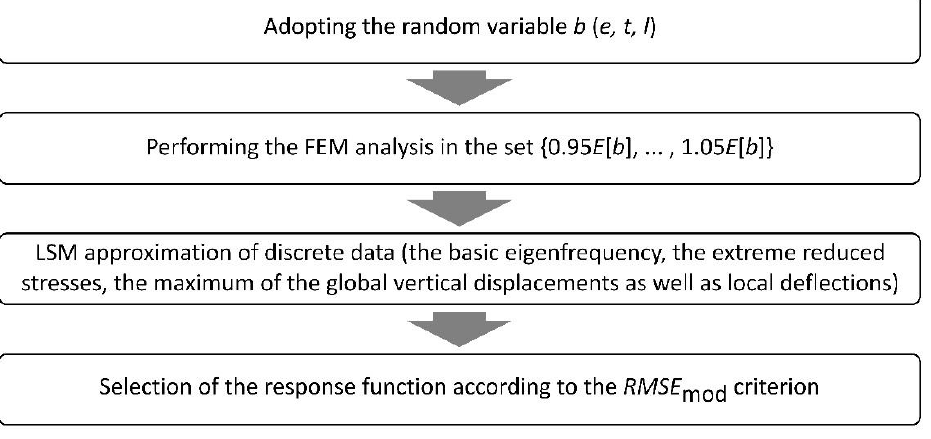
Figure 15. Scheme of the numerical example concerning steel diagrid grillages.